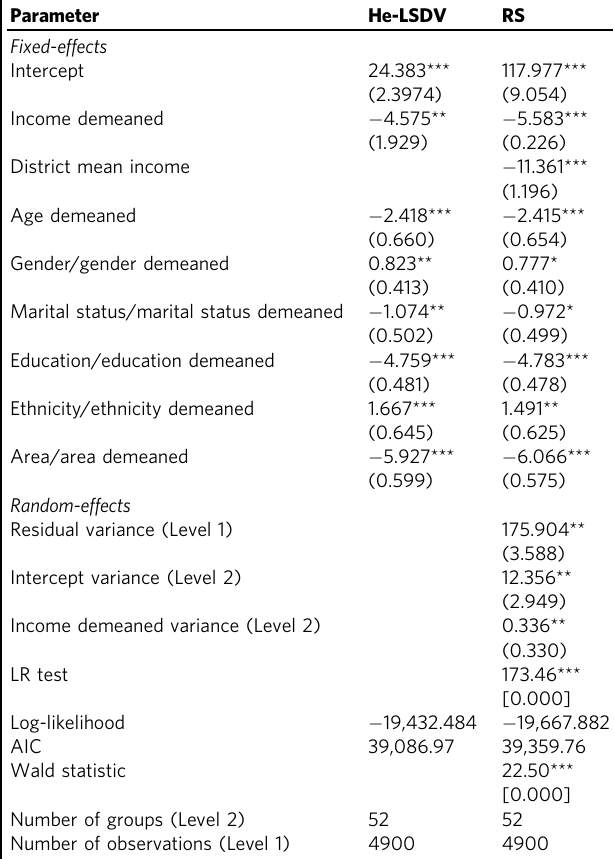
Table 5 Results of heterogeneous